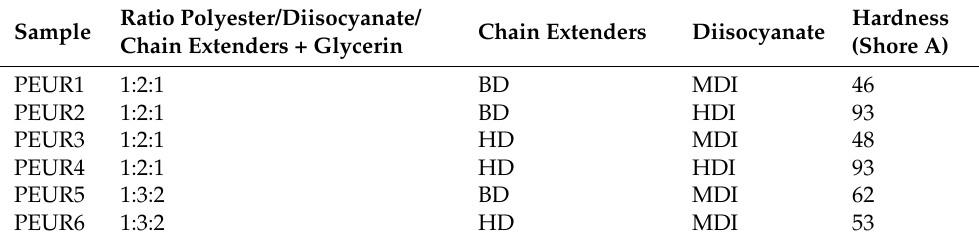
Table 1. The composition of the poly(ester urethane) elastomers